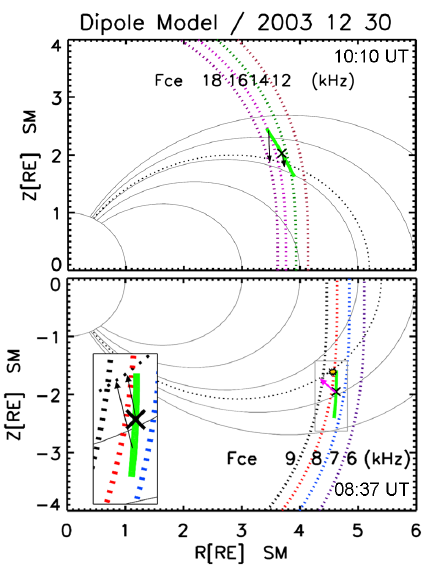
Figure 2. Meridian view of a dipole magnetic field model for the event of 30 December 2003. The Earth contour and L shells ( L = 3 to 7) are plotted in black. C3 orbit elements are shown as thick green lines. IsoFce curves (dashed squares) are drawn in various colours, according to the indicated F c e values. Plasmapause boundaries are shown as black dashed lines. Top: outbound orbit element, from 10:00 to 10:20UT. The X mark indicates C3 position at 10:10UT. The black arrows join two successive positions of the satellite to the two associated source positions. Bottom: inbound orbit element, from 08:26 to 08:46UT, including a detailed inset of the region of interest (sidebar on the left). The position of C3 at 08:37UT is shown by an X mark and the source position visible then by a yel- low symbol. The pink arrow is aligned with an indicative orientation of the wave vector derived from spin modulation. Black arrows in the sidebar as in the top